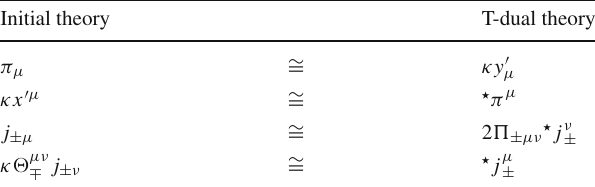
Table 1 Transformations under the T-dualization Initial theory T-dual